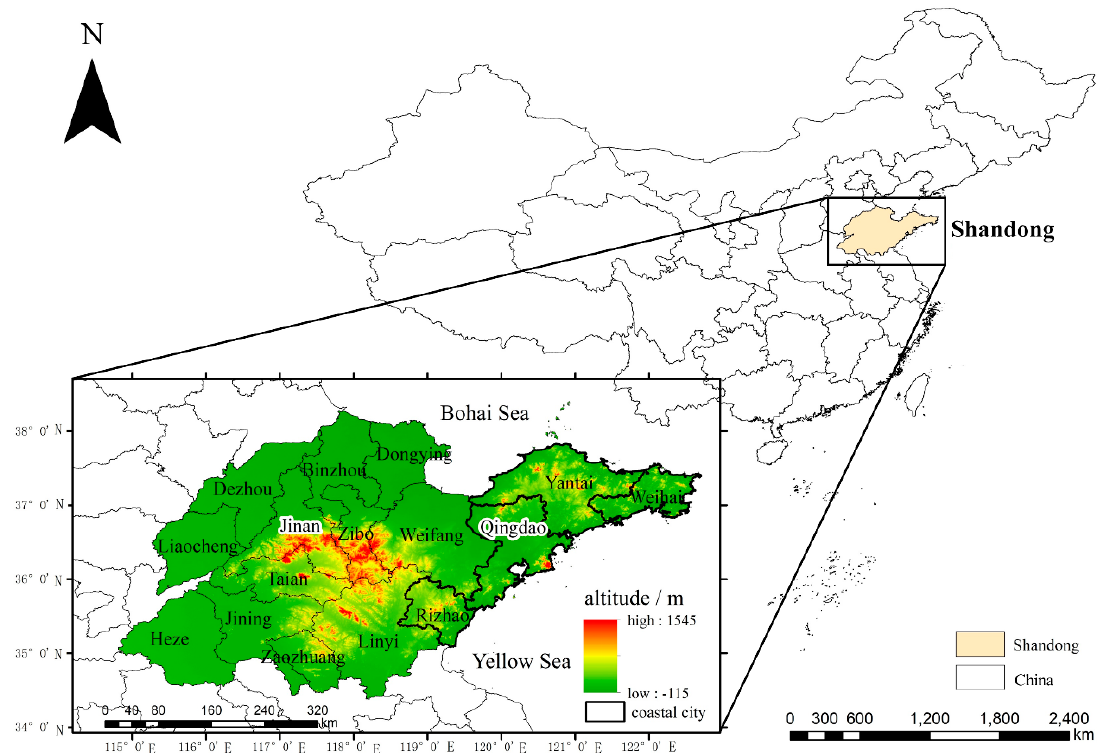
Figure 1. Location of the study area.